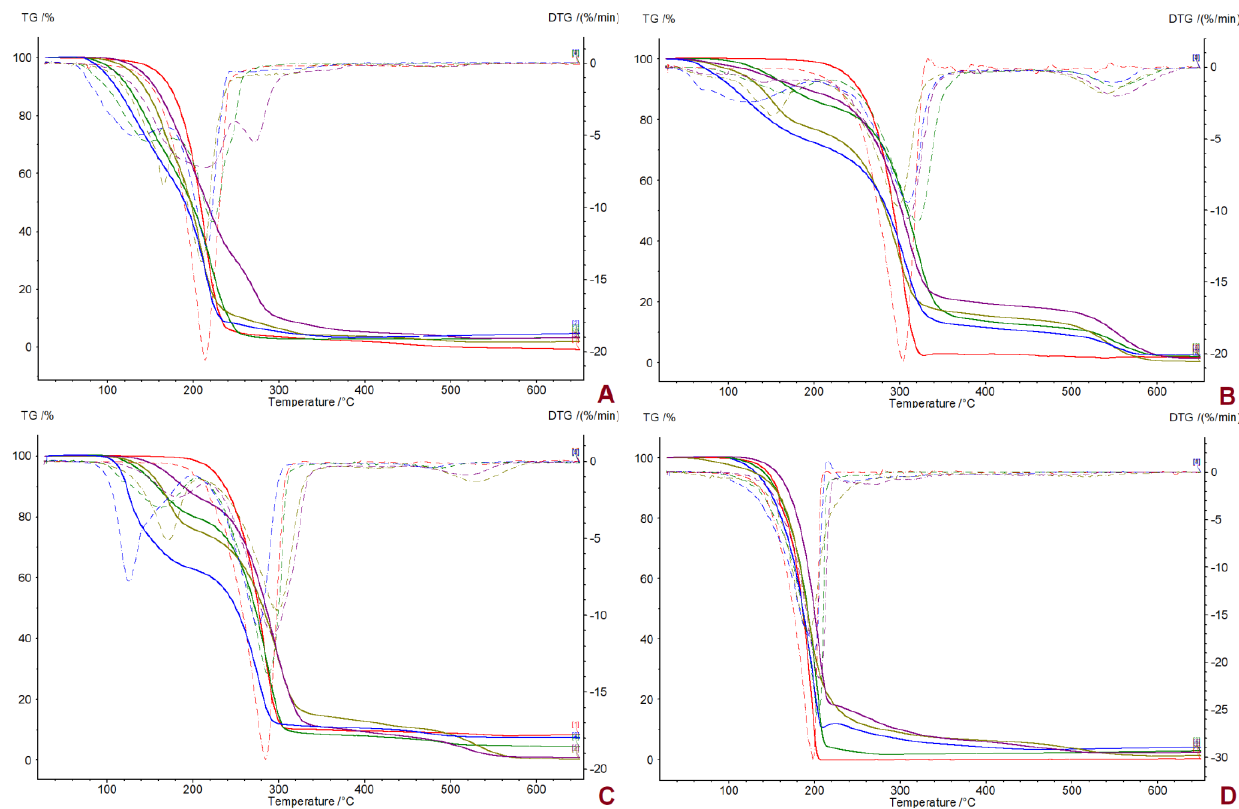
Figure 1. The TG (straight line) and DTG (dotted line) curves of ibuprofen ( A ), ketoprofen ( B ), naproxen ( C ) and salicylic acid ( D ) and their salts, from the top: unmodified acid (red), salts of [L − ValOiPr](blue), salts of [L − IleOiPr] (green), salts of [L − ThrOiPr] (yellow-green), and salts of [L − MetOiPr] (purple).